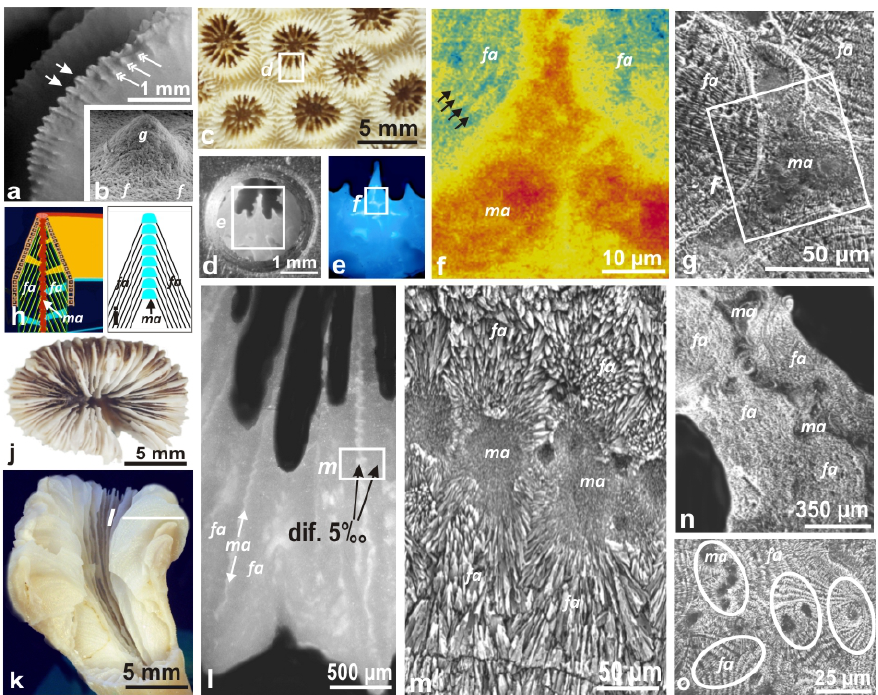
Figure 5. Dual crystallization and environmental recording in coral skeletons. ( a – d ) The two mineralization areas in coral skeletons are illustrated here by a lateral view of a septum of a Colpophyllia coral (from Guadalupe, Caribbean archipelago): spines of the growing edge (a: arrows) produce short lateral branches appearing as granules of the septum sides (a: double arrows); SEM view ( b ) show the long recognized specific microstructure of these growing edge areas (b: g ) well distinct from fibrous tissues (b: f = fibers seen from their distal tips); ( c – e ) Synchrotron-based XANES mapping in a Montastrea corallite. c: Morphology of the corallite; d: polished surface on the sample holder; e: studied surface under UV illumination to locate the distal mineralization areas (microgranular); f: distribution of sulfur from sulfated polysaccharides by XANES method: note the higher content in polysaccharides of the median mineralizing areas and the clearly visible banding pattern in the fibrous area (black arrows). ma : microgranular area, fa : fibrous area; ( g ) Etching made after XANES mapping reveals the skeletal microstructure of the corresponding area: tiny microgranules of aragonite ( ma ) are visible in the median (=distal) area, as well as the stepping growth mode of fibers on both sides. ( h , i ) Scheme of the stepping growth-mode of a coral septum, viewed from a section perpendicular to the septal plane. ( j – m ) Difference in δ 18 O between the two distinct mineralizing domains (median area made of tiny granular crystals and fibers, on both sides of the median area) in the septum of a Desmophyllum ; ( n – o ) Either continuous (n: section in a septum of a Favia corallite) or discontinuous as in the skeletons of the Porites colonies ( o ), a significant differences in isotopic fractionation or minor element partitioning is always found between microgranular and fibrous mineralizing areas. In 5o, ellipses exemplify how sampling positioning may result in important dispersion of the measured values depending on the proportions of the two distinct mineralizing areas involved in the